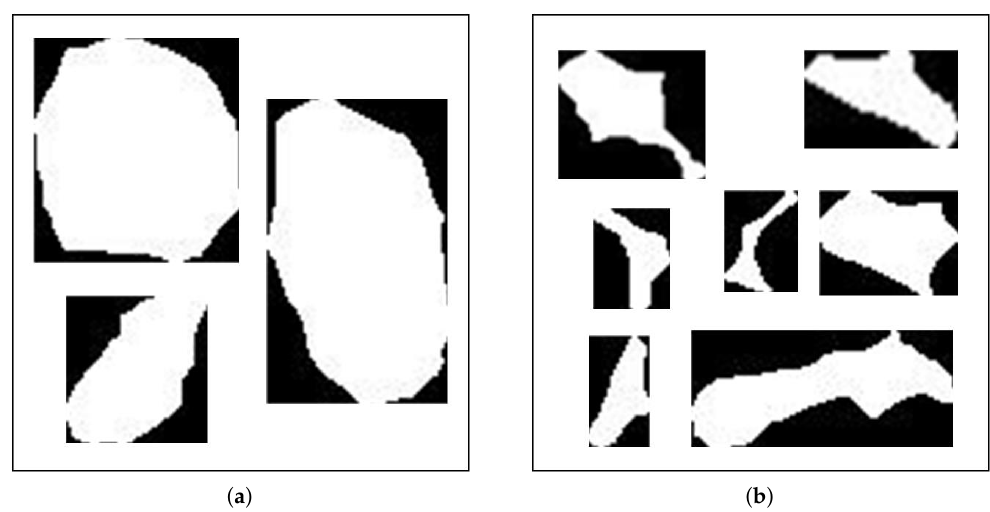
Figure 10. Images of microstructural elements: ( a ) cells and ( b ) intercellular